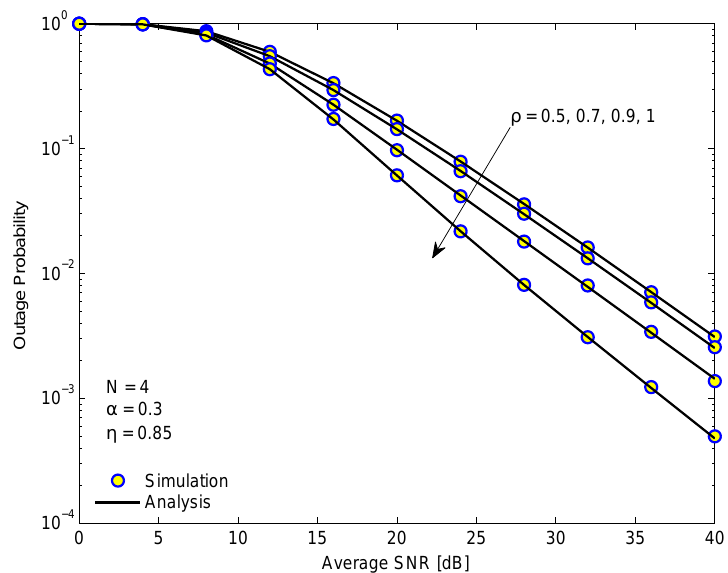
Figure 3. The outage probability of D 1 in the EH-NOMA relaying system versus the average SINR for different correlation coefficients.